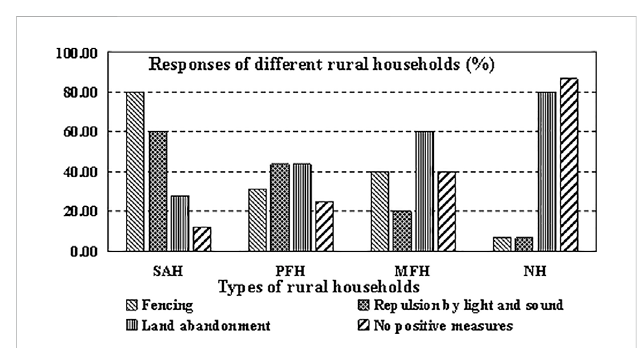
FIGURE 5 Mitigation measures practiced by different households in the study area. Note: SAH means specialized agriculture households, PFH means pure farm households, MFH means mixed farm-business households, NH means non-farm